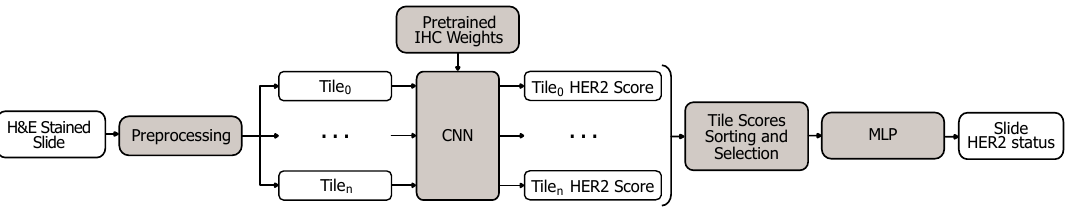
Figure 3. The proposed approach for weakly-supervised HER2 status classification on BCa H&E stained slides.